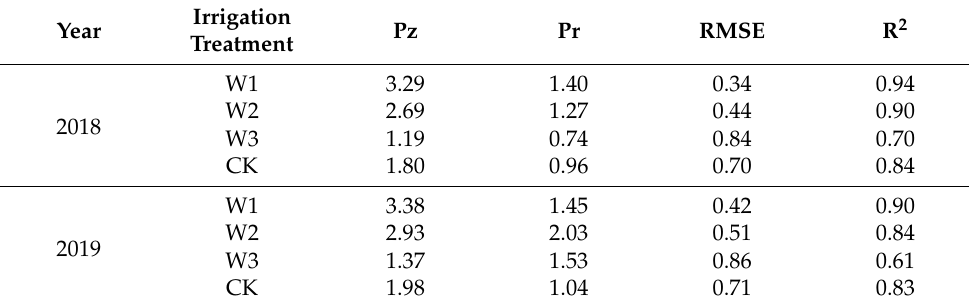
Table 4. Simulation results of jujube root two-dimensional distribution model.